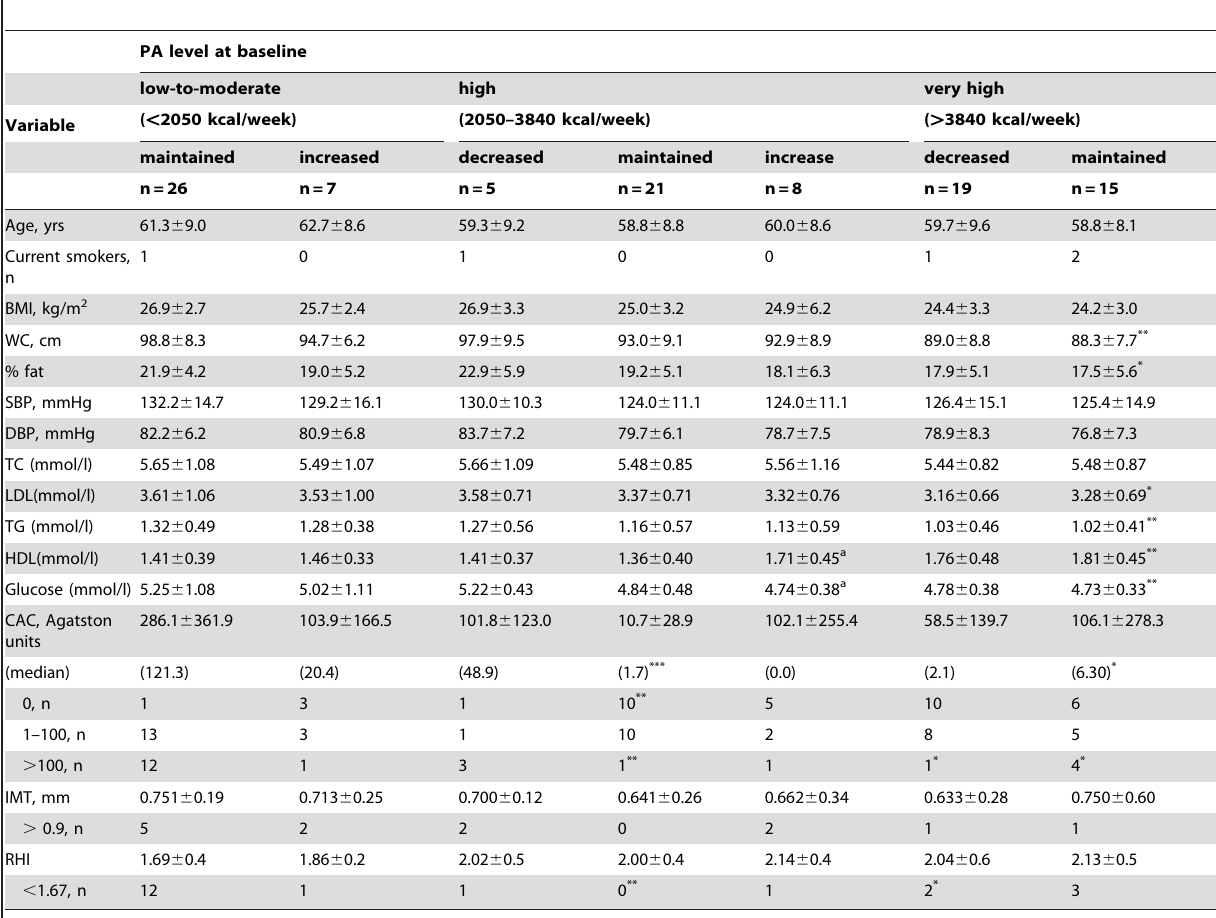
Table 2. Traditional CVD risk factors and indices of subclinical atherosclerosis during final examination (2011/12) according to physical activity patterns during 25-year